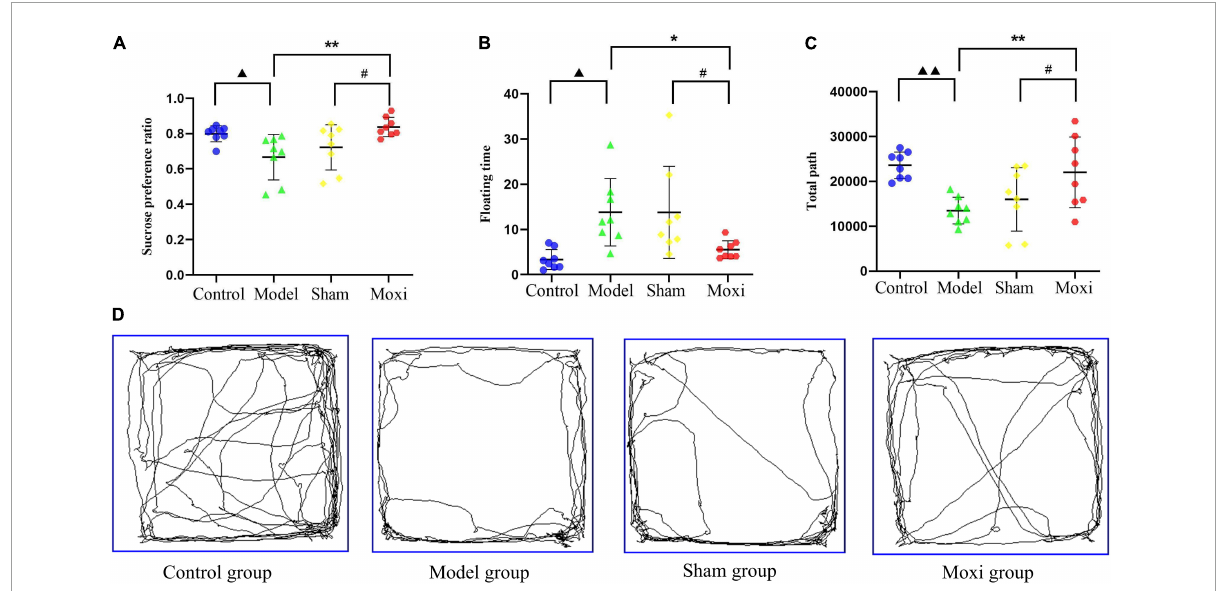
FIGURE3 Effect of moxibustion on alleviating depression-like behavior. (A) Sucrose preference ratio, (B) Floating time, (C) Total path, and (D) Activity trajectory in the open field experiment of rats in each group. n = 8 per group. (cid:78) P < 0.05 vs. control group, (cid:78)(cid:78) P < 0.01 vs. control group; * P < 0.05, ** P < 0.01 vs. model group; # P < 0.05 vs. sham group.